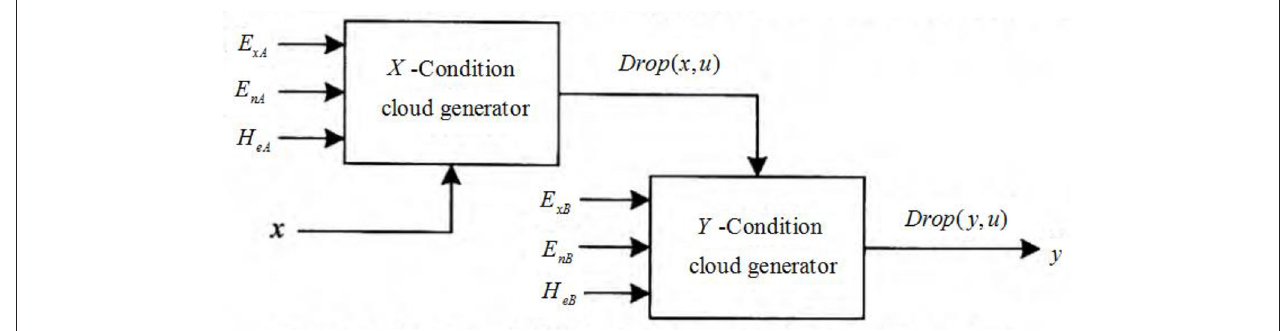
FIGURE 1 | Cloud language prediction rules based on uncertain